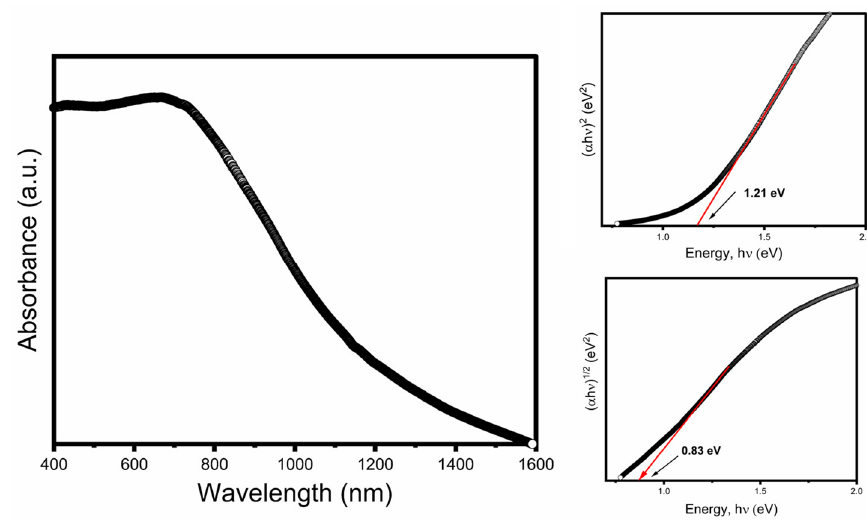
Figure 6. UV-vis absorption spectrum of dispersed CuCrS 2 . The inset shows Tauc plot and extrapolation of the linear portion of the curve on the X-axis at zero absorption to determine the bandgap.